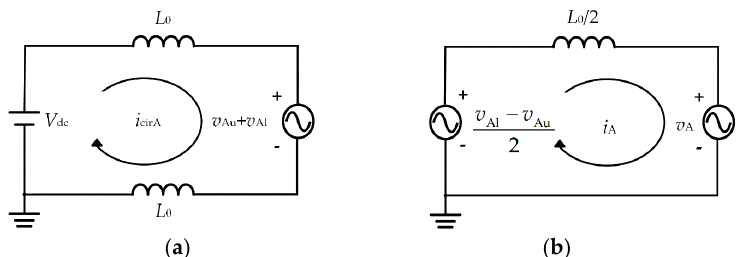
Figure 4. The equivalent circuit of phase A. ( a ) DC-side equivalent circuit, ( b ) AC-side equivalent